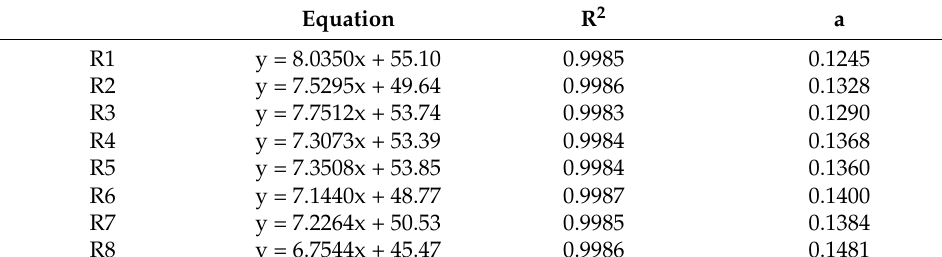
Table 2. Stress-relaxation equation in R1–R9.